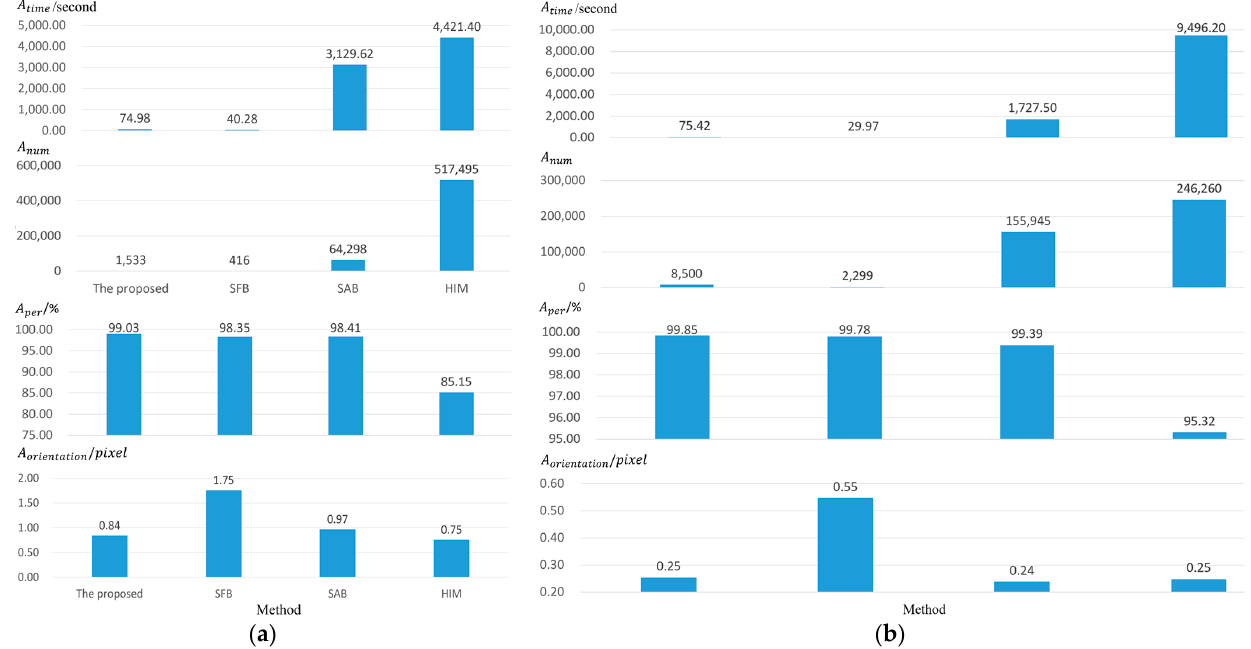
Figure 9. Evaluations of different methods. ( a ) Omaha data. ( b ) Tibet data. The sub-figure of 𝐴 (cid:3047)(cid:3036)(cid:3040)(cid:3032) in Figure 9 shows that the matching time of SFB and the